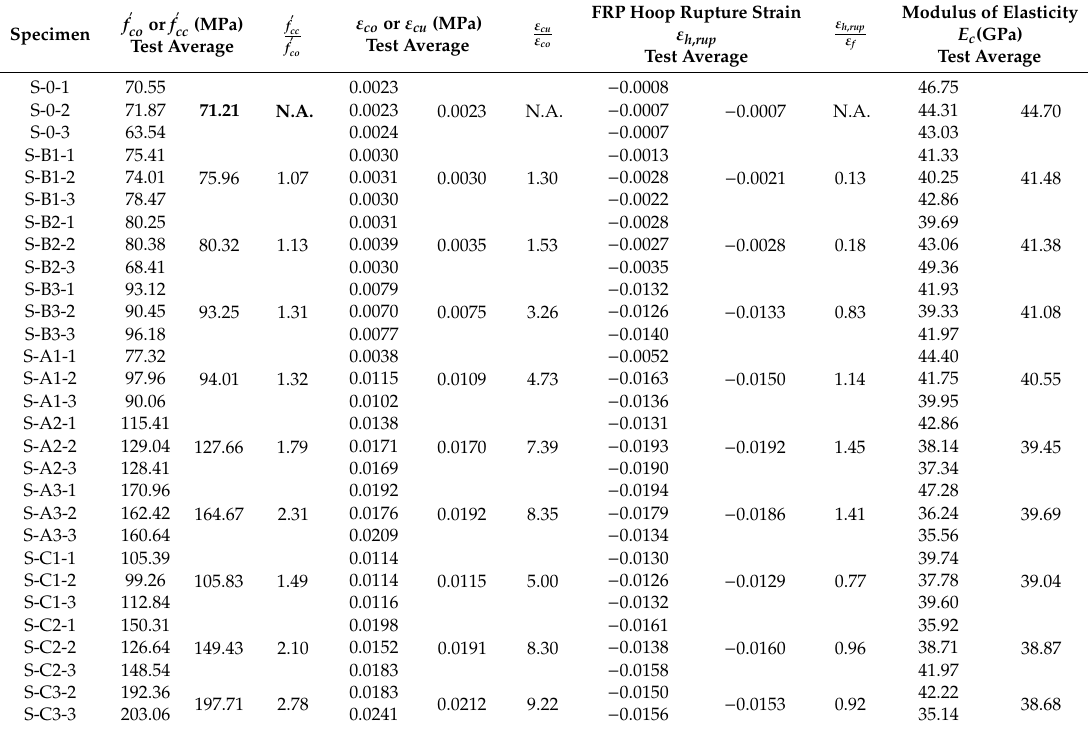
Table 3. Test results of specimens under quasi-static compression